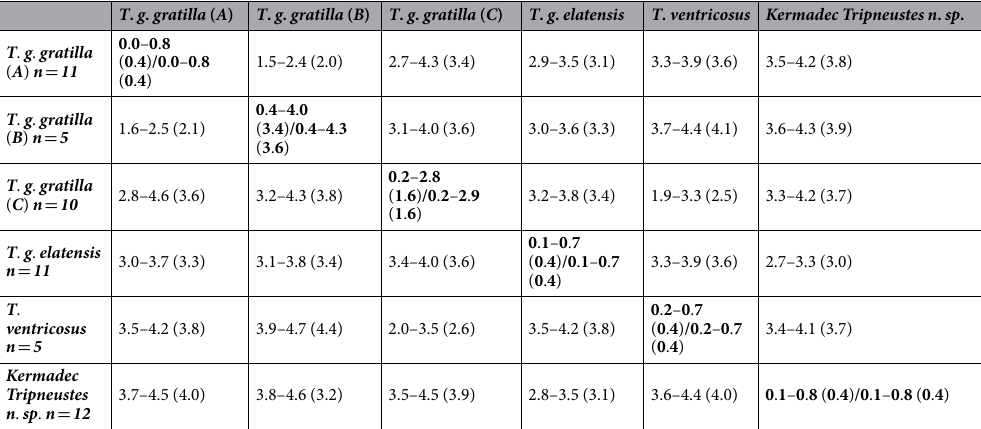
Table 2. Intraspecific and interspecific distances (in percent) within Tripneustes based on the nuclear bindin dataset. Ranges and means (in brackets) of p-distances between (above diagonal) and within (diagonal, before slash) clades as well as K2P distances between (below diagonal) and within (diagonal, after slash) groups are shown. Letters in brackets by clade names correspond to the clade names in Fig. 8, n corresponds to the number of